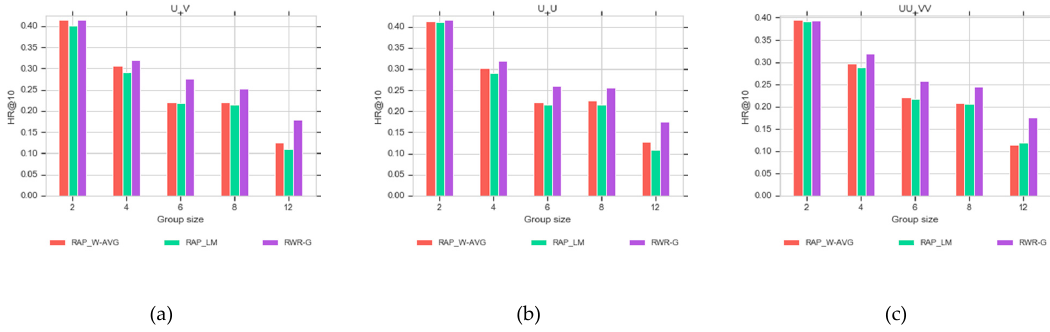
Figure 8. HR values of the RWR algorithm at top-10 recommendations (vertical axis) in different group recommendation strategies, including RAP_LM, RAP_W-AVG, and RWR-G at different group sizes (horizontal axis) and three graph models: ( a ) U-V graph; ( b) U-U graph, and ( c ) UU-VV graph.